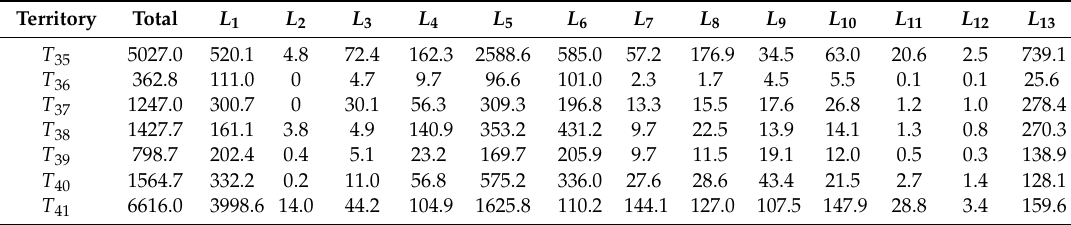
Table A4. Land acreage data of the North Caucasian Federal District in thousand hectares. Mean values for 2010–2018. Territory